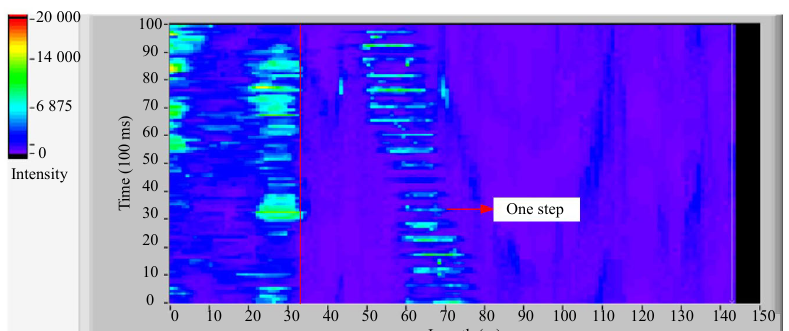
Fig. 7 Schematic diagram of walking experiment.